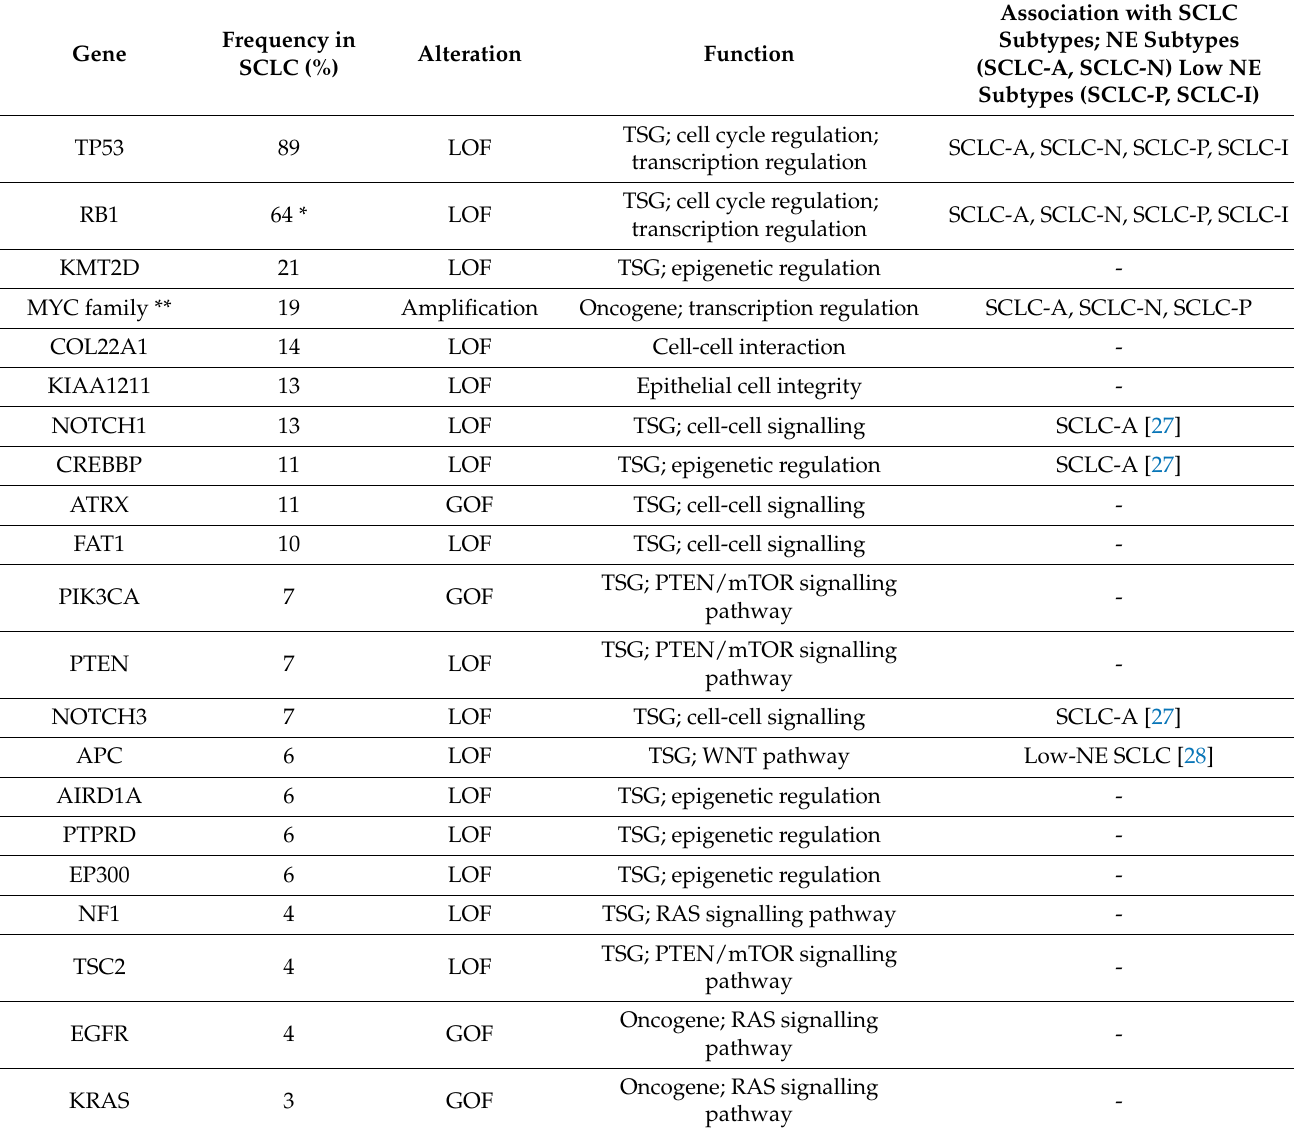
Table 1. Frequently altered genes in SCLC. Data from large scale sequencing studies representing frequently altered genetic alterations in SCLC [13,25]. Data adapted from MSK-IMPACT targeted next- generation sequencing [25], MSK-MET study [26], George et al., Comprehensive genomic profiles of small cell lung cancer [13]. * RB1 mutations are likely to be underrepresented, as it is often inactivated by complex genomic events which are not traceable with sequencing techniques [13]. ** MYC family genes (MYCL1, MYCN, MYC) SCLC, Small-cell lung cancer; LOF, loss of function; GOF, gain of function; TSG, tumor suppressor